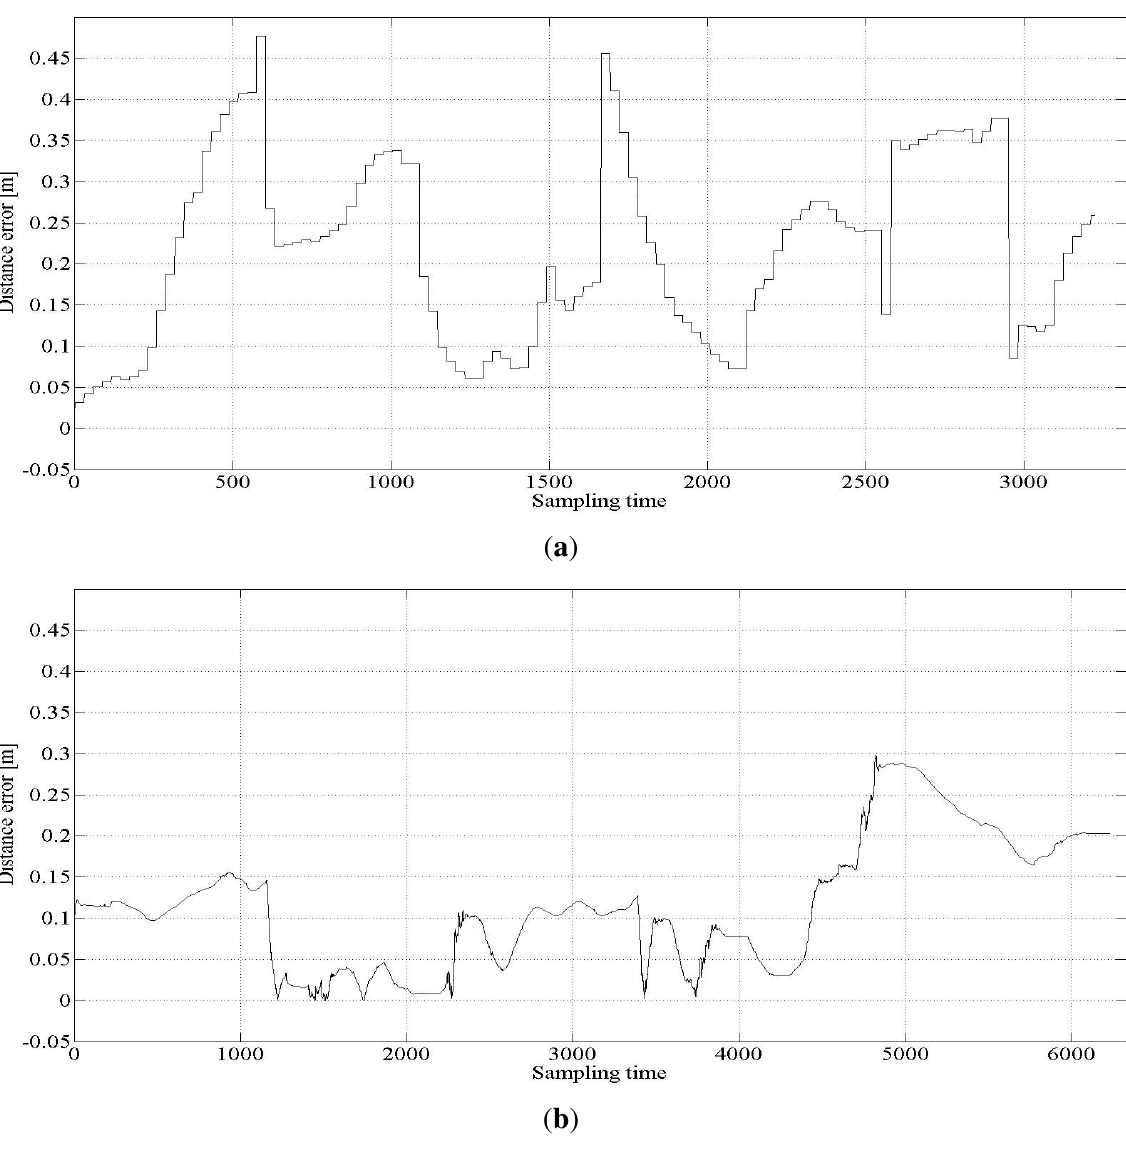
Figure 6. Distance error for the three cases. ( a ) Distance error for the case of USAT only (Case 4); ( b ) distance error for the case of LRF only (Case 5). Table 7. Rate of associating correct correspondence for each beacon range measurement for Cases 3 and